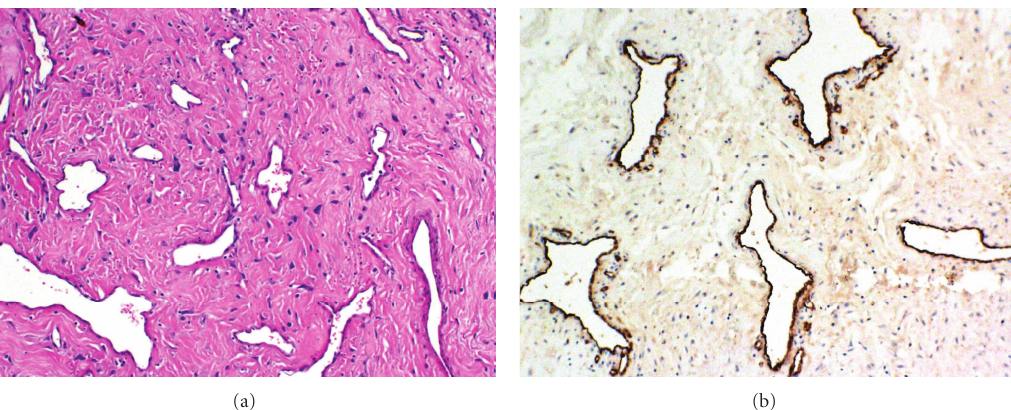
Figure 1: Microscopic appearance of JA (hematoxylin-eosin staining (a) and immunohistochemistry for factor VIII (b)). Vessel caliber is extremely variable, the muscular layer of vessels is frequently absent, and stromal cells have usually a spindle-shaped